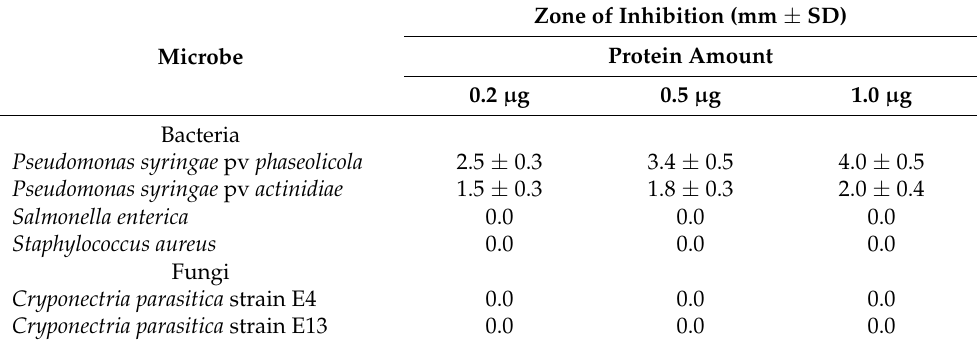
Table 4. Antimicrobial activity of quinoin from the seeds of Chenopodium quinoa . The assays were carried out as reported in the ‘Material and Methods’ section and the values shown were obtained from three independent